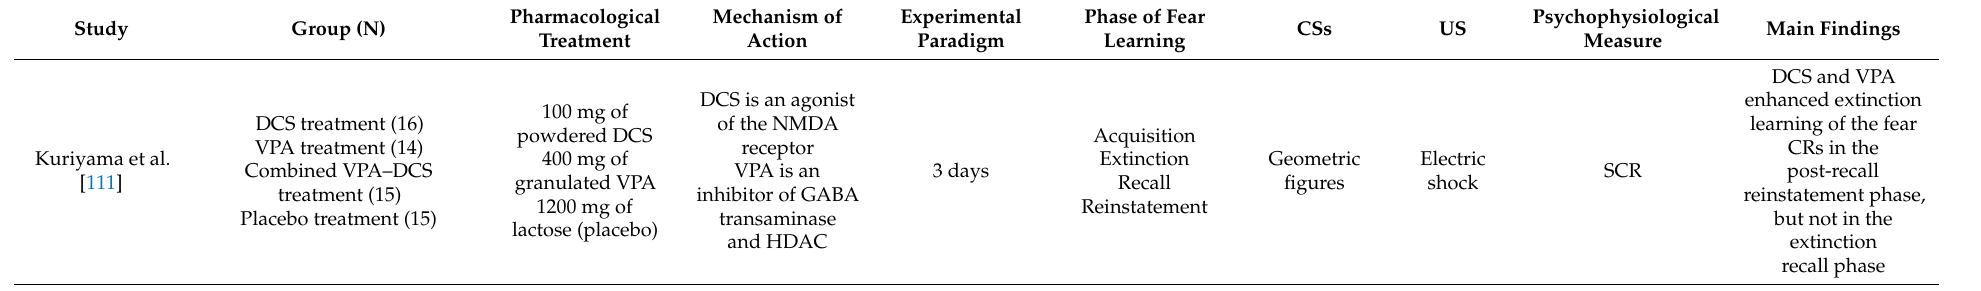
Table 1. Summary of findings in studies with the administration of NMDA agonist